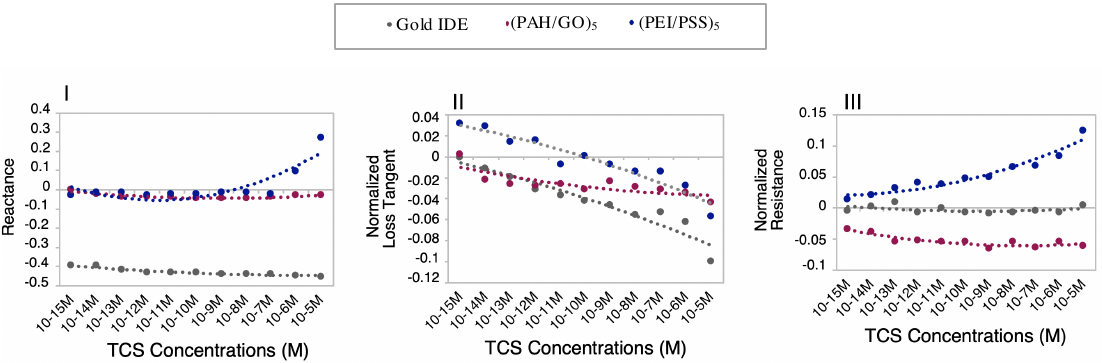
Figure 3. Normalized transducing variables as a function of TCS concentrations at fixed frequencies: I) DW—reactance spectra at 6.3, 25,119, and 25,119 Hz; II) MW—loss tangent spectra at 63,095, 16,000, and 100,000 Hz; and III) EF—resistance spectra at 100,000, 16,000, and 3981 Hz; to gold IDE, (PAH/GO) 5 and (PEI/PSS) 5 sensors, respectively ( n = 3, average and standard deviations of the respective impedance data used for the normalization, in Supplementary Material Figures S5.1, 5.2, and 5.3).